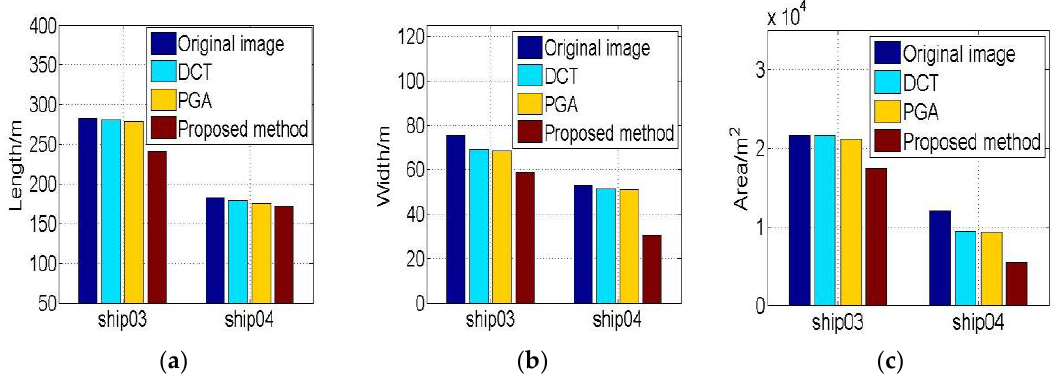
Figure 14. The geometrical features of refocusing ship03 and ship04. ( a ) Lengths of ships; ( b ) Widths of ships. ( c ) Areas of ships.